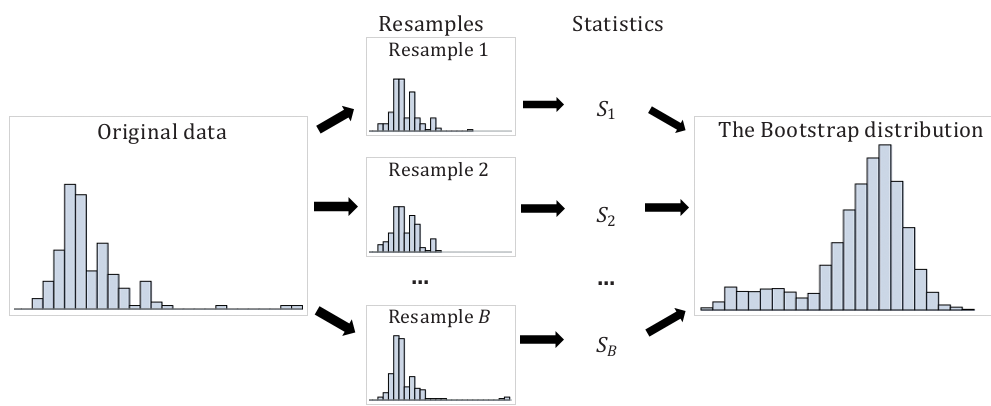
Figure 4. Bootstrapping method (Wiklin,